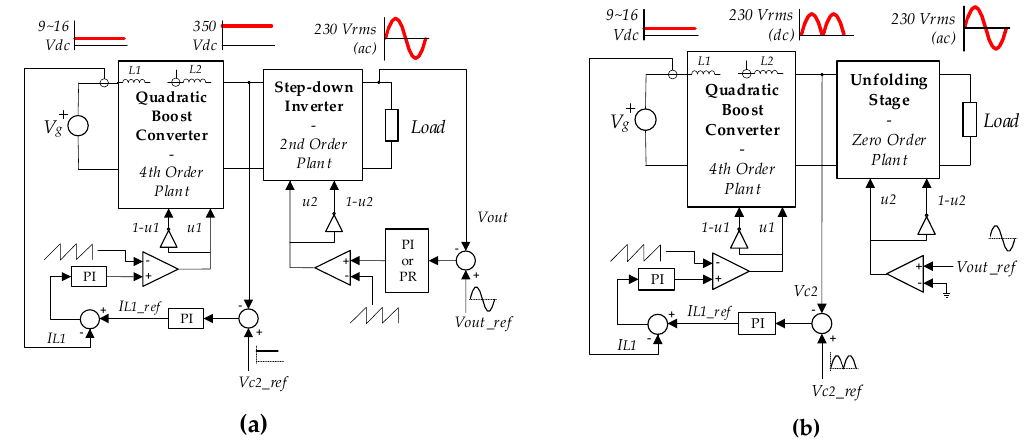
Figure 5. Common and proposed approaches with PWM control: ( a ) common case (slow-fast): 6th order plant, 9th -10th order system depending on inverter controller; ( b ) fast-slow strategy: 4th order plant, 6th order system.